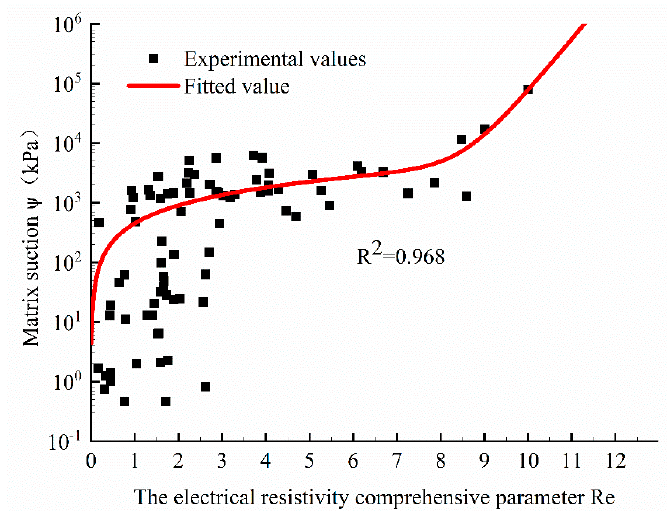
Figure 8. 𝜓 − 𝑅 (cid:3032) Fitting curve. Figure 8. ψ - R e Fitting